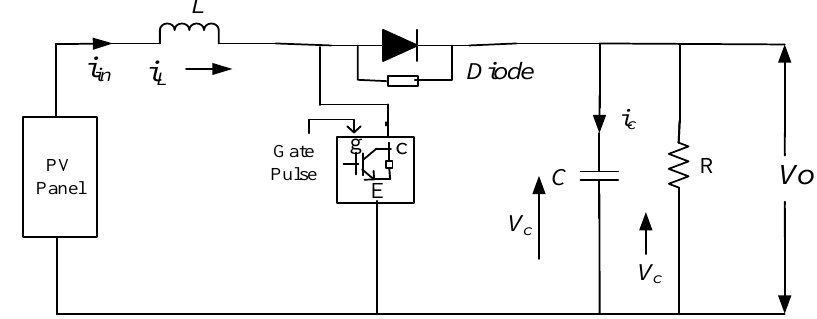
Figure 2. System configuration for photovoltaic (PV) based DC-DC Boost converter.